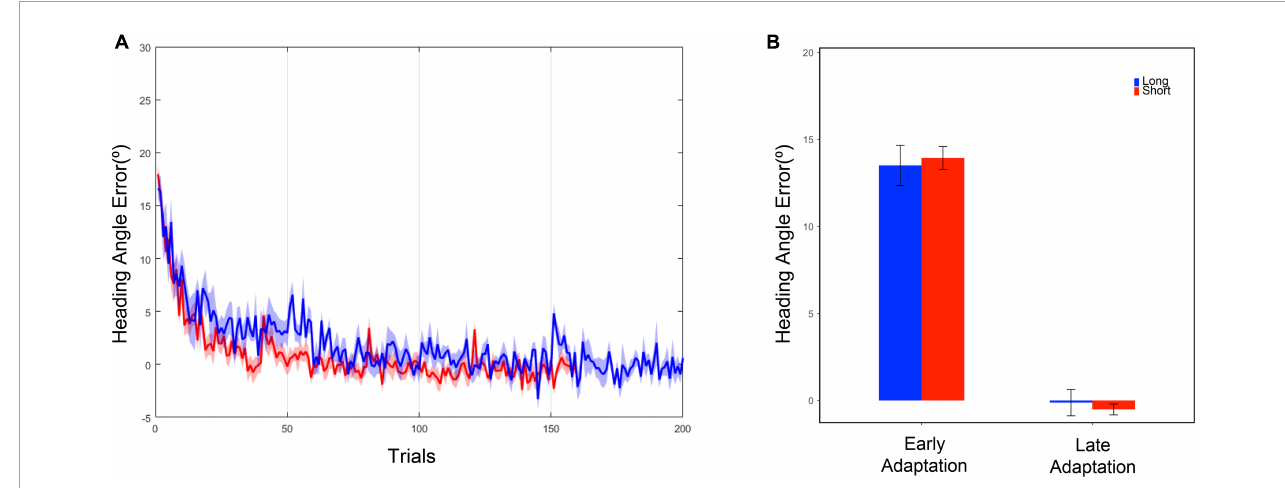
FIGURE3 (A) Heading angle error curve. The blue line represents the mean, and the blue shadow represents the standard error of the mean of the long task group. The red line represents the mean, and the red shadow represents the standard error of the mean of the short task group. (B) Heading angle error in the early and late adaptation period. Each bar represents the mean of heading angle error, and the error bar represents the standard error of mean. The early adaptation period represents the first five trials of the adaptation phase, and the late adaptation period represents the last five trials of the adaptation